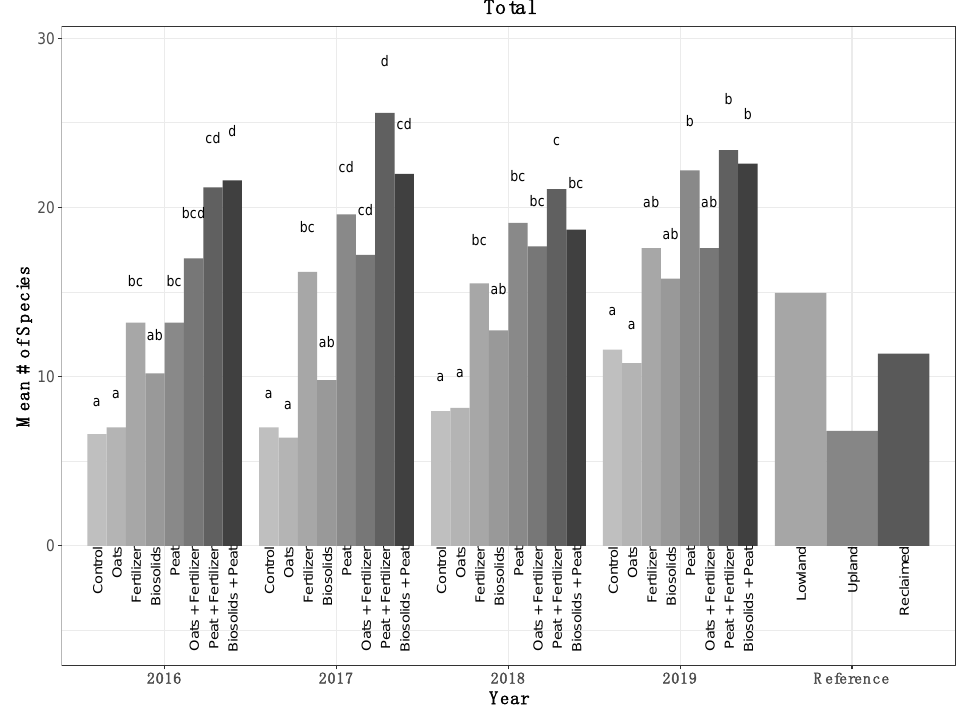
Figure 3. Mean vascular plant alpha diversity by treatment. Within each year, treatments marked with different letters indicates a statistically significant difference ( p < 0.05).